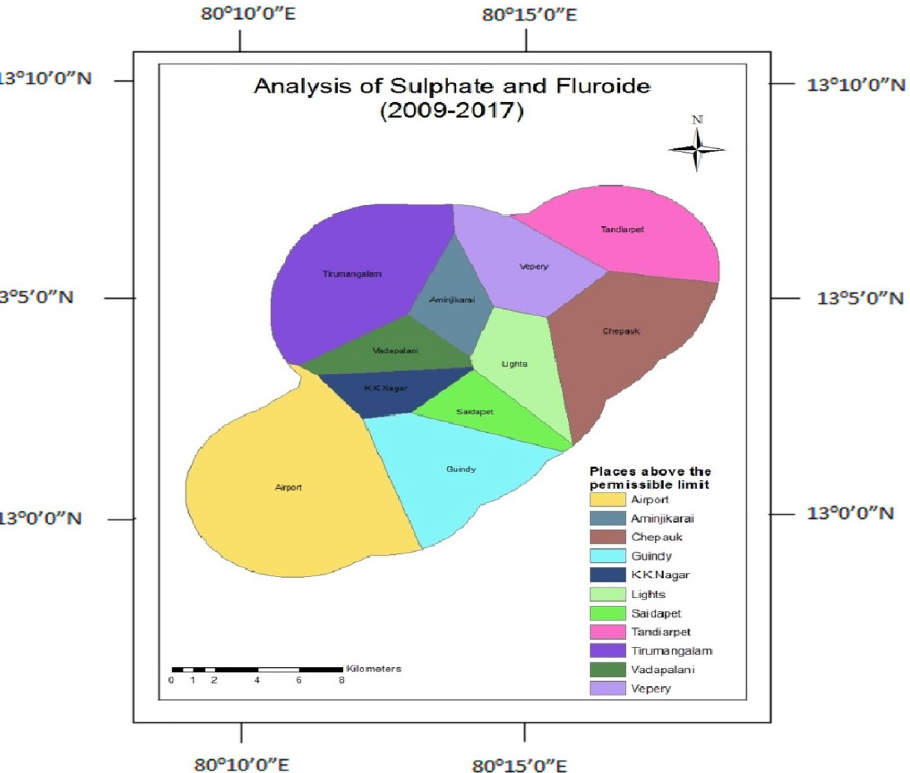
Figure 18. Analysis of fluoride and sulphate for